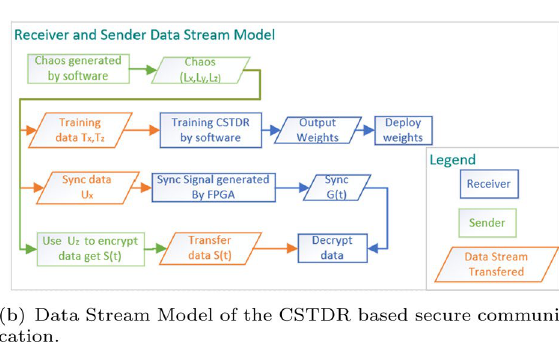
Fig. 10 Detailed working process of the CSTDR-based secure communication scheme